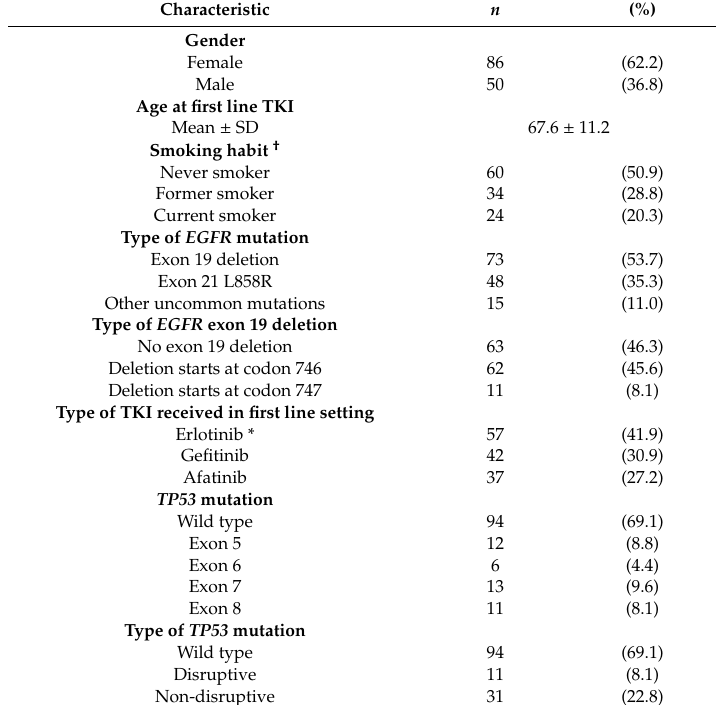
Table 1. Demographic, clinicopathological and molecular characteristics of patients ( n =